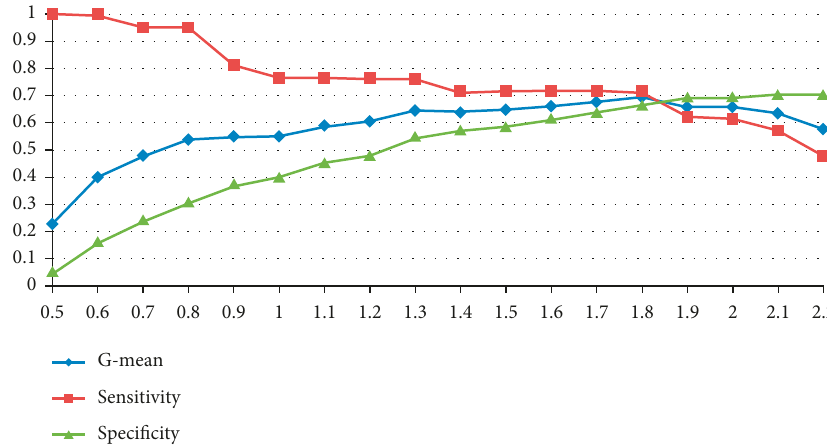
Figure 14: Performance values of SWAB on GS with different merging thresholds.